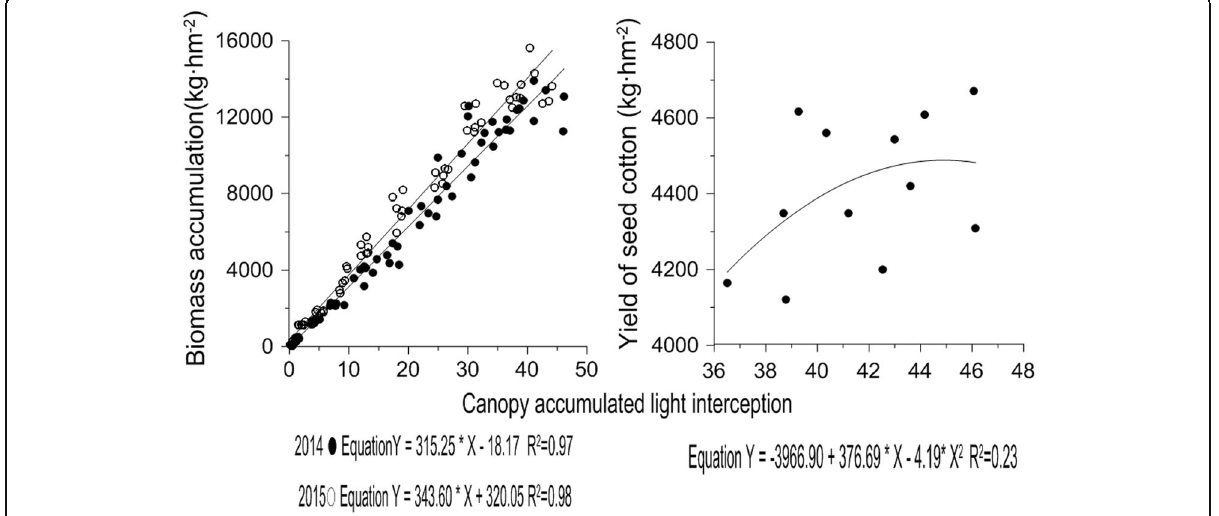
Fig. 6 Relationships of LI with biomass and yield for six cotton varieties with different plant types in 2014 and